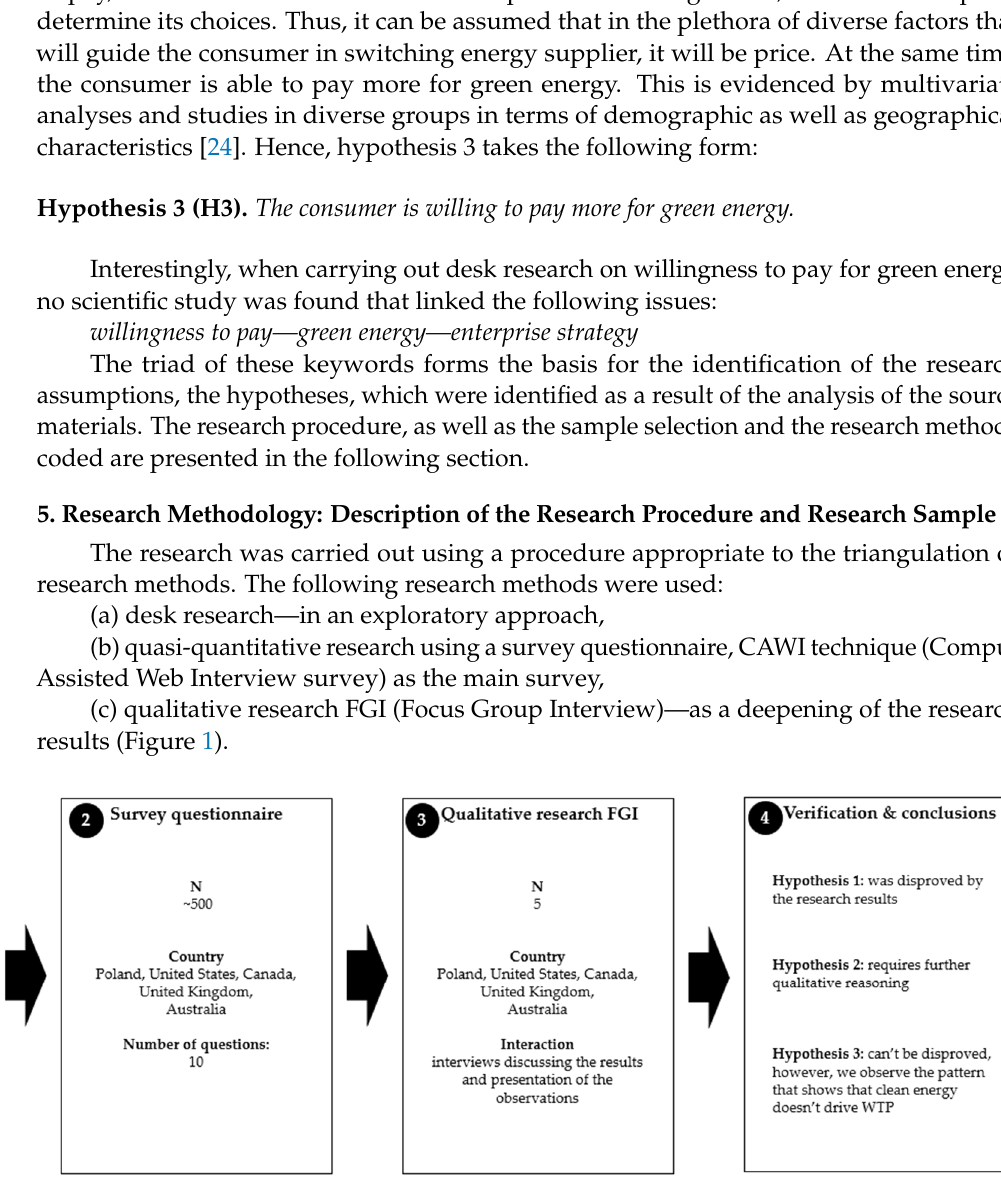
Figure 1. Research process for the presented study. Source: own study.